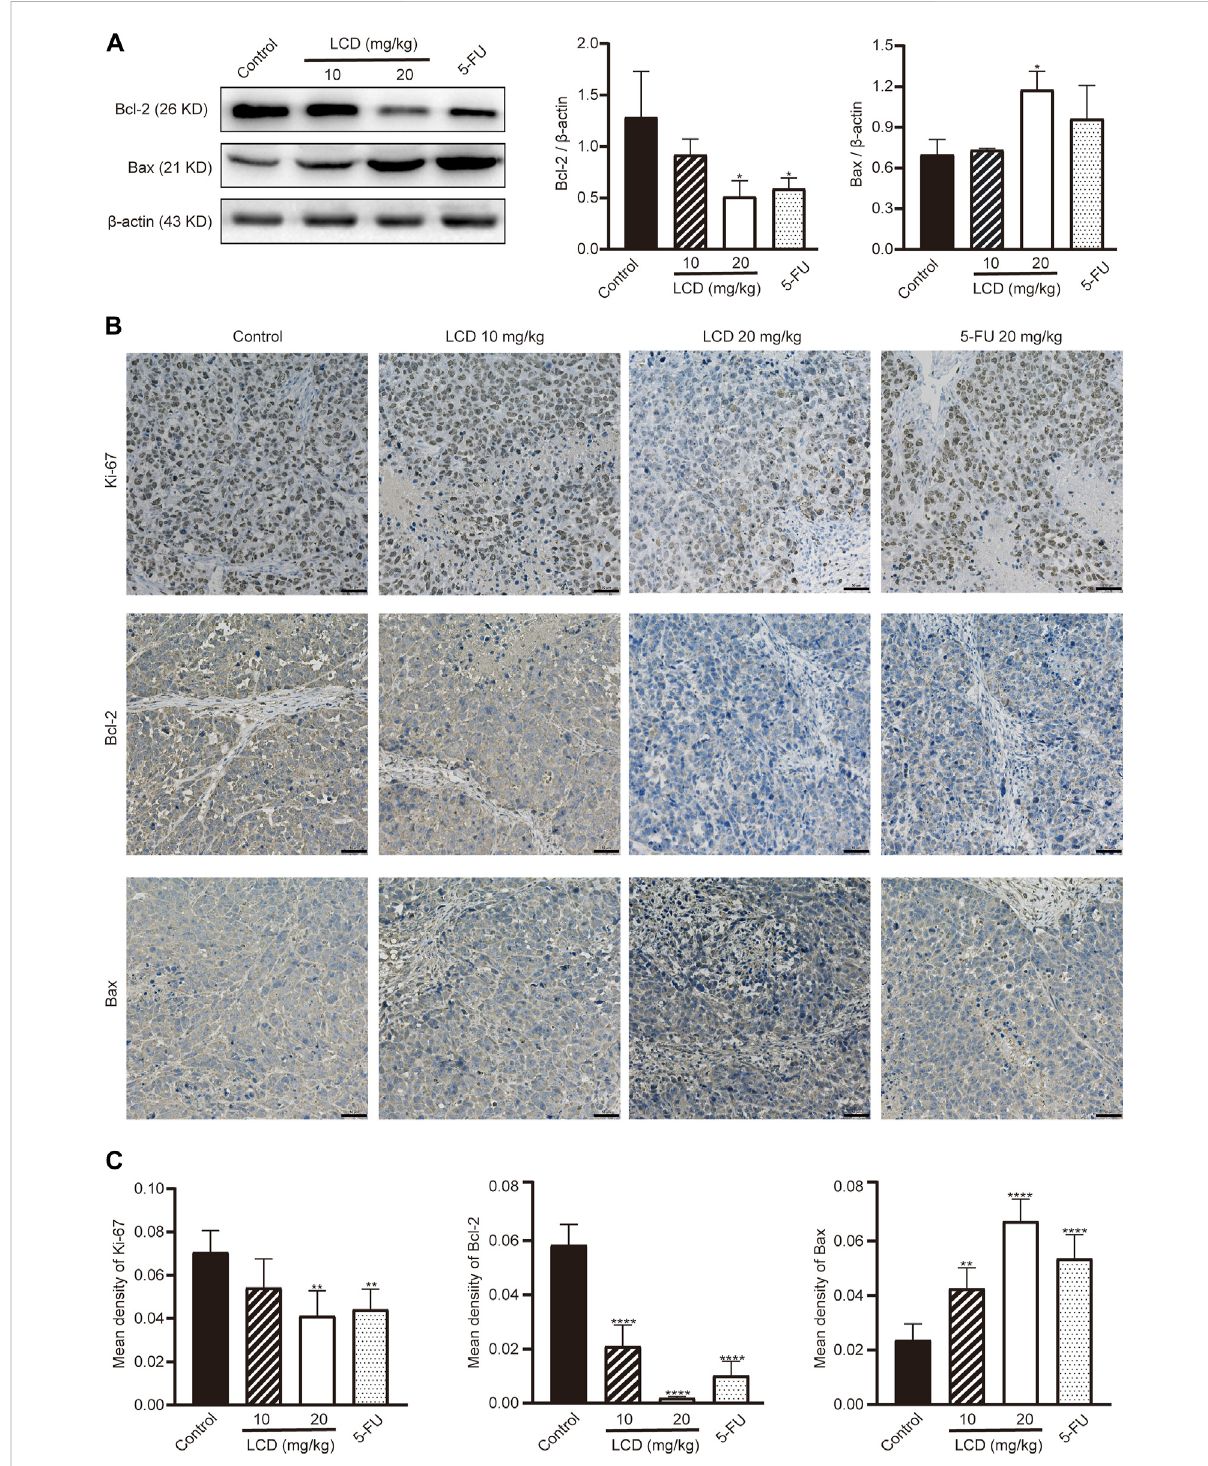
FIGURE 5 Licoricidin repressed proliferation and induced apoptosis of MGC-803 cells in vivo. (A) Expression levels of apoptosis-related proteins (Bcl- 2 and Bax) in the xenografted tumor were measured by Western blot assay and normalized by β -actin for quantitative analysis. Independent experiments were repeated three times. (B) Immunohistochemistry was used to evaluate the levels of proteins related to proliferation (Ki-67) and apoptosis (Bcl-2 and Bax) in xenograft tumors. (C) Mean densities of positively expressed proteins were calculated from fi ve random fi elds of view by Image-Pro Plus 6.0 software for quantitative analysis. Values are expressed as mean ± SD, * p < 0.05, ** p < 0.01, and **** p < 0.0001. LCD, licoricidin. 5-FU, 5- fl uorouracil. Scale bar, 50 μ